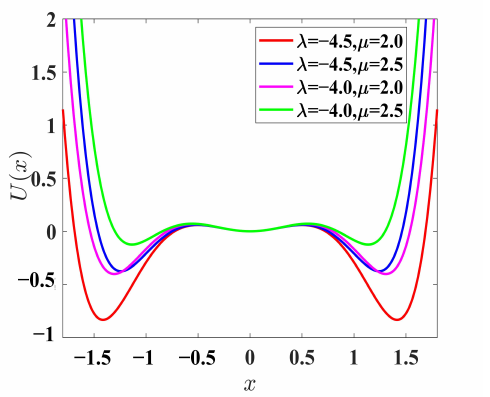
Figure 2. Potential functions of the